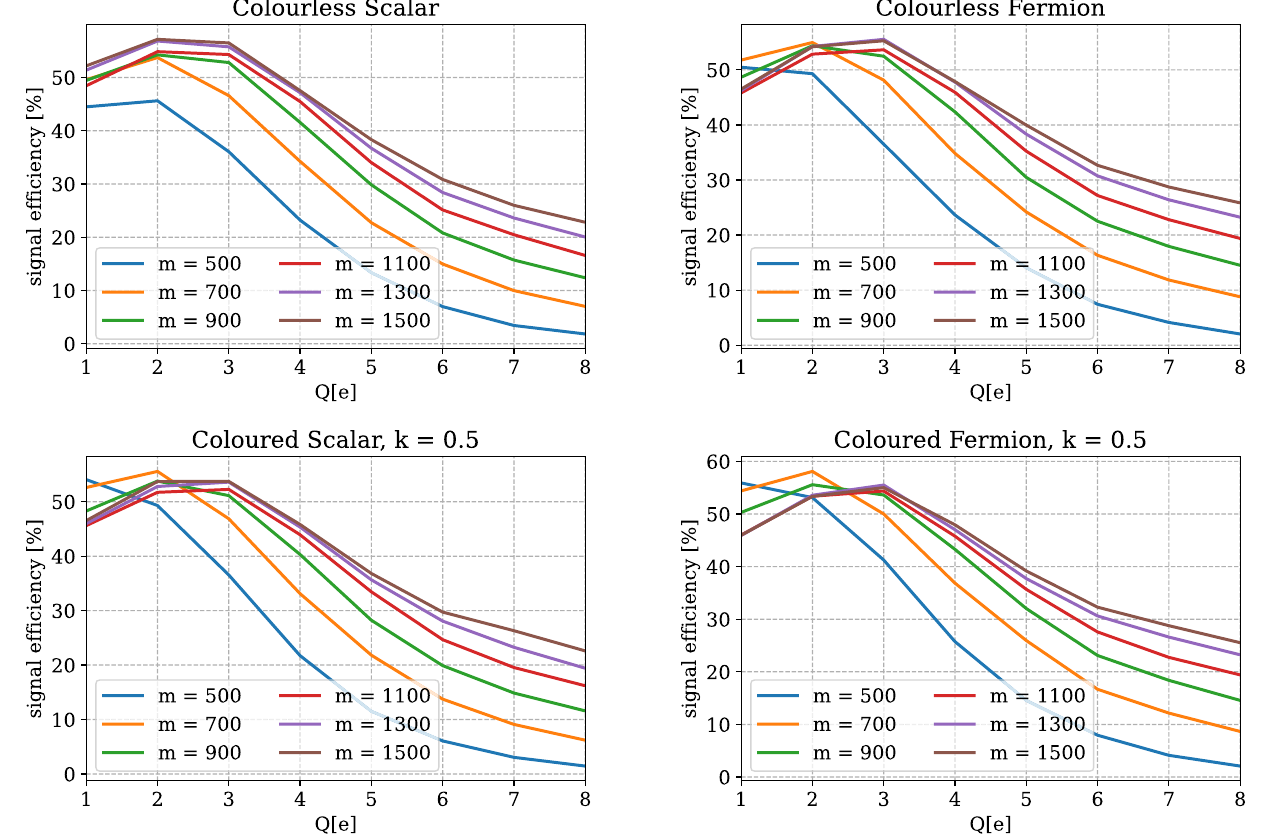
Fig. 6 Top left: the signal efficiencies for different colourless scalars masses (in GeV), versus charge. Top right: same but for colourless fermions. Bottom left(right): same but for coloured scalars (fermions)